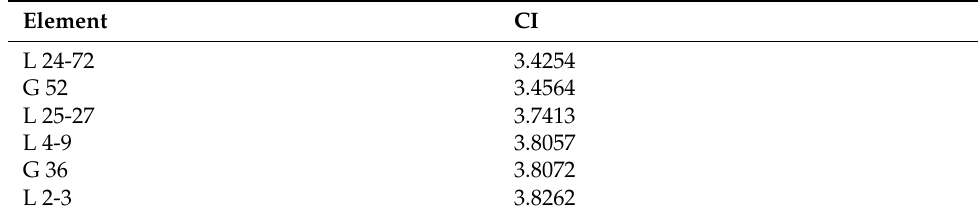
Table 4. Contingency index by disconnected